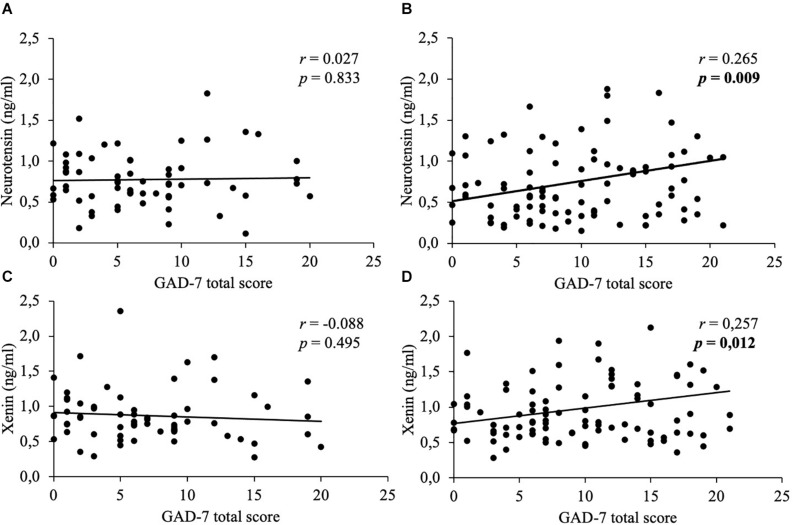
Correlations between neurotensin and xenin with GAD-7 total scores in men and women. Overall, in women neurotensin (B) and xenin (D) showed a positive correlation with GAD-7 total score, while for men no significant correlations with GAD-7 total score were detected, neither for neurotensin (A) nor for xenin (C). Correlations were calculated using Pearson’s analysis. GAD-7, Generalized Anxiety Disorder-7.